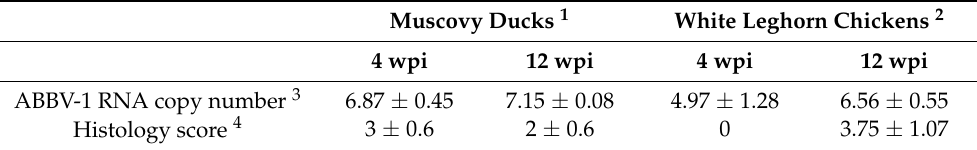
Table 1. Virus RNA copies and histological scores of the brains of Muscovy ducks and chickens infected with ABBV-1 by the intracranial route, assessed at 4 and 12 weeks post-infection